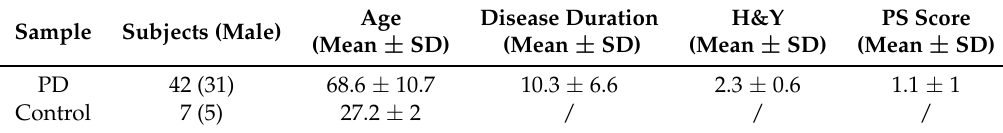
Table 1. Demographic and clinical characteristics of subjects involved in this study.